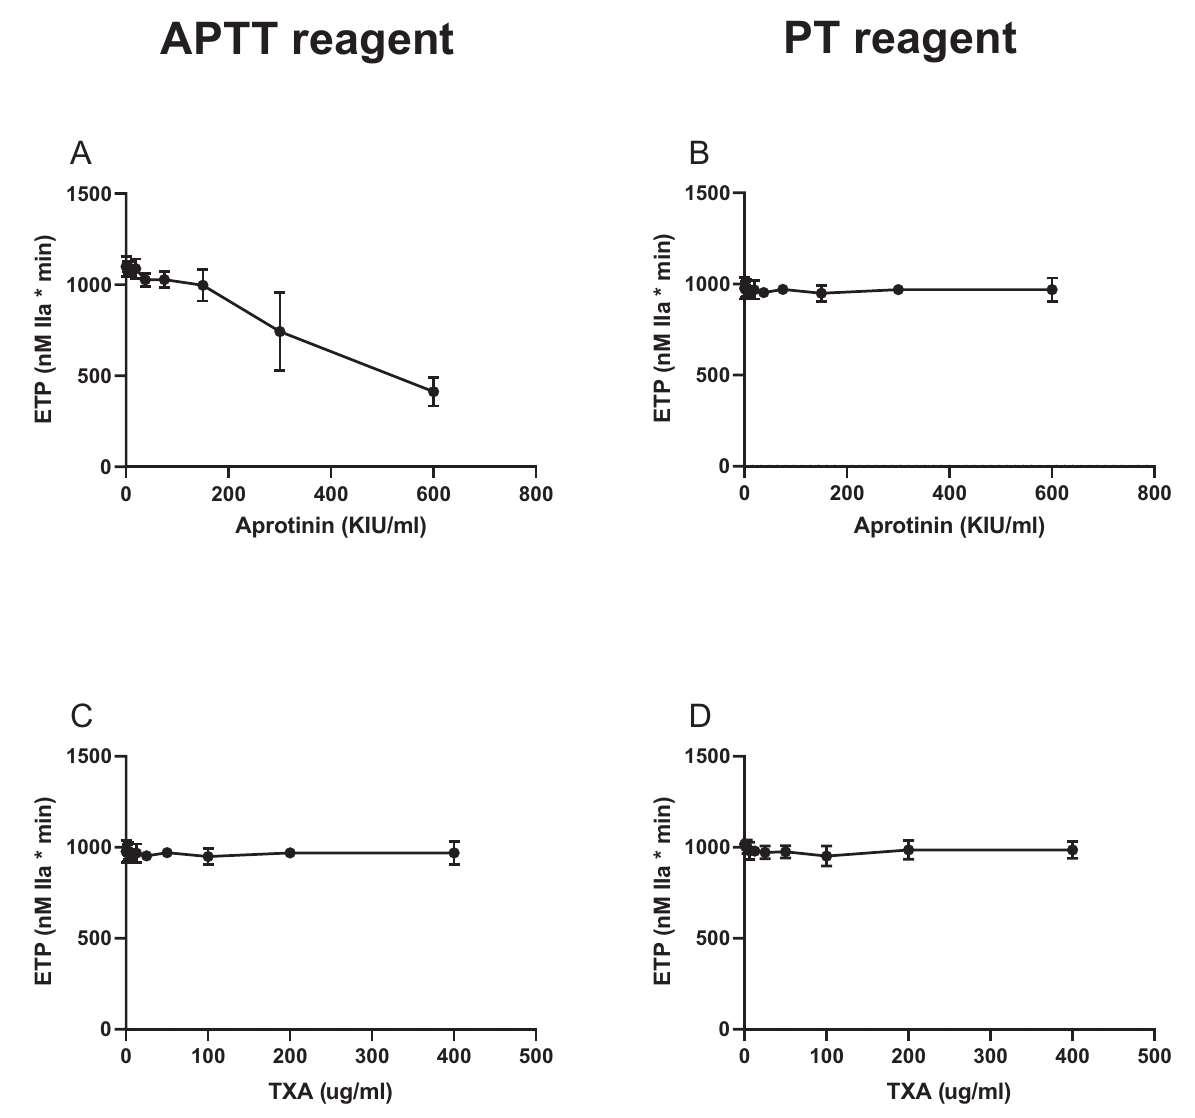
Fig. 3 Effects of aprotinin and TXA on the Endogenous Thrombin Potential (ETP). Aprotinin and TXA were added to pooled normal plasma in increasing concentrations and samples were subjected to calibrated automated thrombinography. Coagulation was initiated by a dilute APTT reagent ( A and C ) or a dilute PT reagent ( B and D ). Shown are mean ETP values derived from thrombin generation curves of 3 independent experiments. Error bars indicate standard